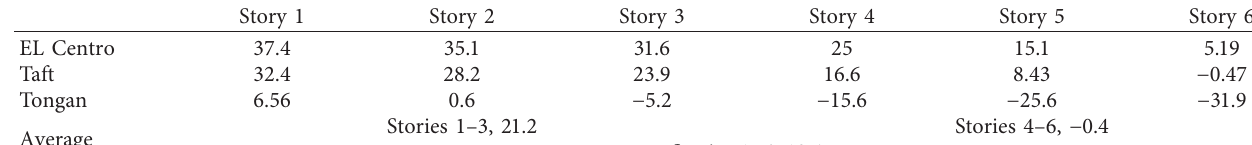
Table 3: Story drift seismic reduction ratio (%).